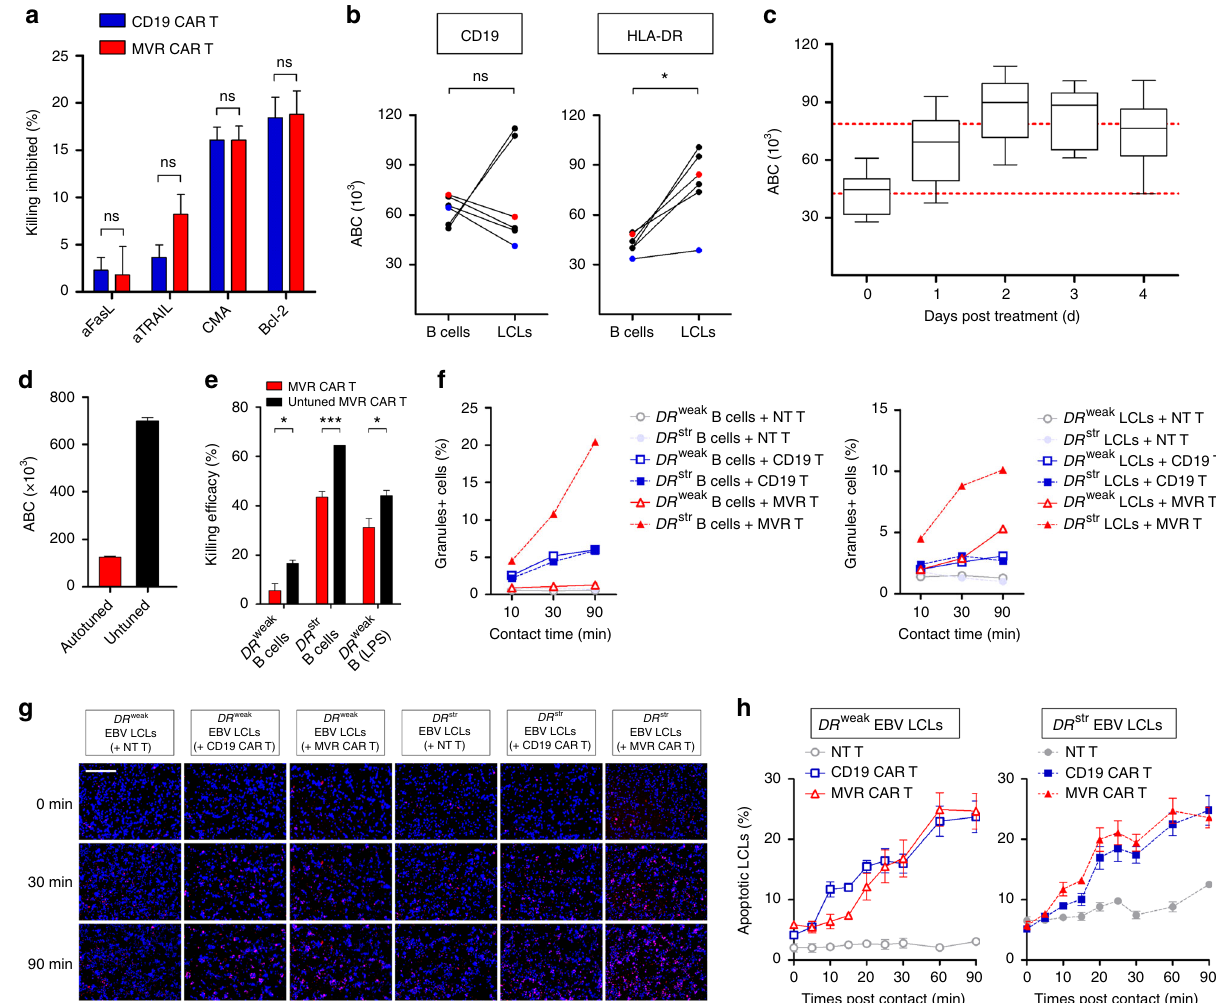
Fig. 4 MVR CAR T cells selectively kill HLA-DR-upregulated EBV LCLs by sensing antigen level. Cells from donors with different HLA-DRB1 alleles exhibiting strong or weak binding to MVR ( DR str or DR weak , respectively; Fig. 1a) were used as follows. a Killing inhibition in the presence of the indicated blocking agents. DR weak EBV LCL killing by each CAR T cell type was measured as in Fig. 3f ( n = 3). b Expression of CD19 and HLA-DR on B cells and EBV LCLs. Antibody binding capacity (ABC) is an index of numbers of target molecules. Dots connected by the same line involve the same donor ( n = 6). Red and blue dots indicate DR weak and DR str cells, respectively. c HLA-DR expression on lipopolysaccharide-stimulated B cells. Cells were analyzed as in b for 4 days ( n = 6). Upper and lower dotted lines indicate average HLA-DR levels of EBV LCLs and B cells, respectively, measured in b . Whiskers indicate minimum and maximum values. d MVR CAR expression on the surface of untuned and autotuned DR weak MVR CAR T cells (day 2 and 12 in Fig. 2c) evaluated as in b ( n = 4). e Killing ef fi cacies of untuned and tuned DR weak MVR CAR T cells evaluated as in Fig. 3f. DR weak B cells, DR str B cells, and DR weak B cells treated with lipopolysaccharide for 3 days were used as target cells ( n = 3). f Proportions of B cells and EBV LCLs containing transferred granules after contact with T cells. Cells contacted for indicated times were analyzed as shown in Supplementary Fig. 6. NT non-transduced. g , h Time-lapse analysis of apoptotic EBV LCLs after contact with T cells. g EBV LCLs (blue) undergoing apoptosis (red) identi fi ed by detecting magenta color (scale bar indicates 250 μ m). h Proportions of apoptotic EBV LCLs at indicated time points. Three different areas of each sample were analyzed. a Representative of three independent experiments. f , h Representative of two independent experiments. a , d , e n indicates biological replicates. a , d , e , h Mean ± s.e.m. b Two-tailed Wilcoxon matched pairs test. a , e Unpaired two-tailed t -test; ns not signi fi cant; * p < 0.05; *** p <